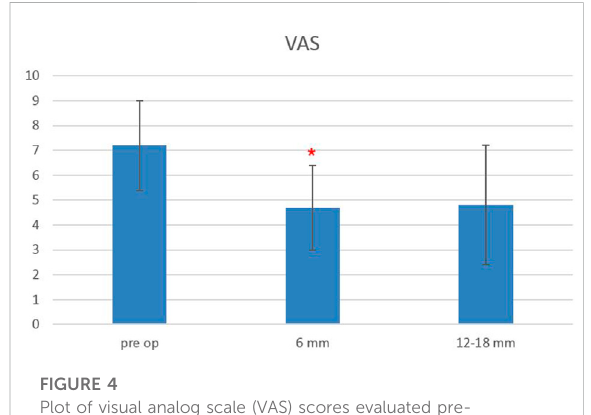
FIGURE 6 EuroQoL-5D(EQ-5D)scoresevaluatedpre-operatively,at6- month and 12 – 18-month follow-ups. The red asterisk depicts a signi fi cant difference between post-operative and pre-operative